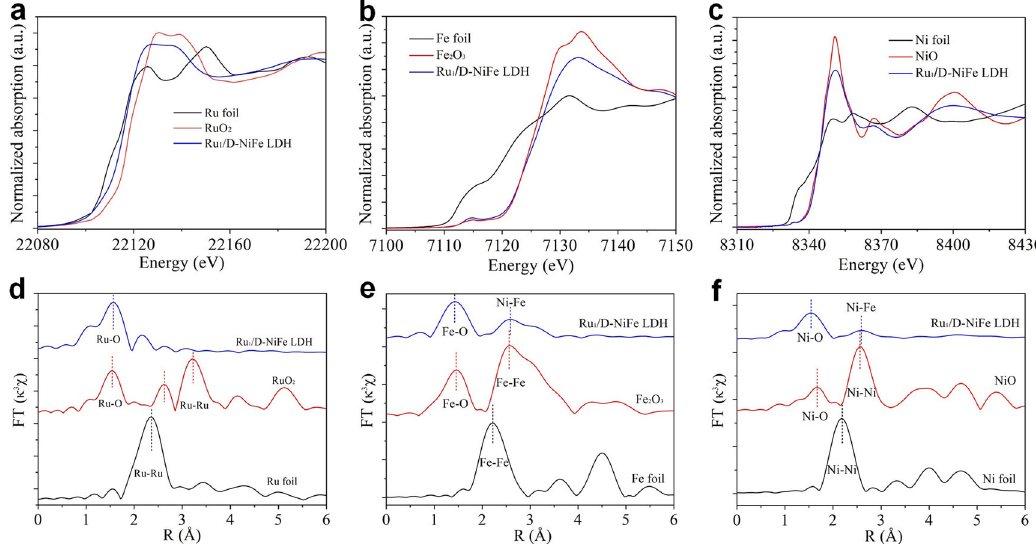
Fig. 2 X-ray absorption spectroscopy characterizations. a XANES spectra at Ru K-edge of Ru 1 /D-NiFe LDH, Ru foil, and RuO 2 . b XANES spectra at Fe K-edge of Ru 1 /D-NiFe LDH, Fe foil, and Fe 2 O 3 . c XANES spectra at Ni K-edge of Ru 1 /D-NiFe LDH, Ni foil, and NiO. d – f Fourier-transform EXAFS spectra from a – c